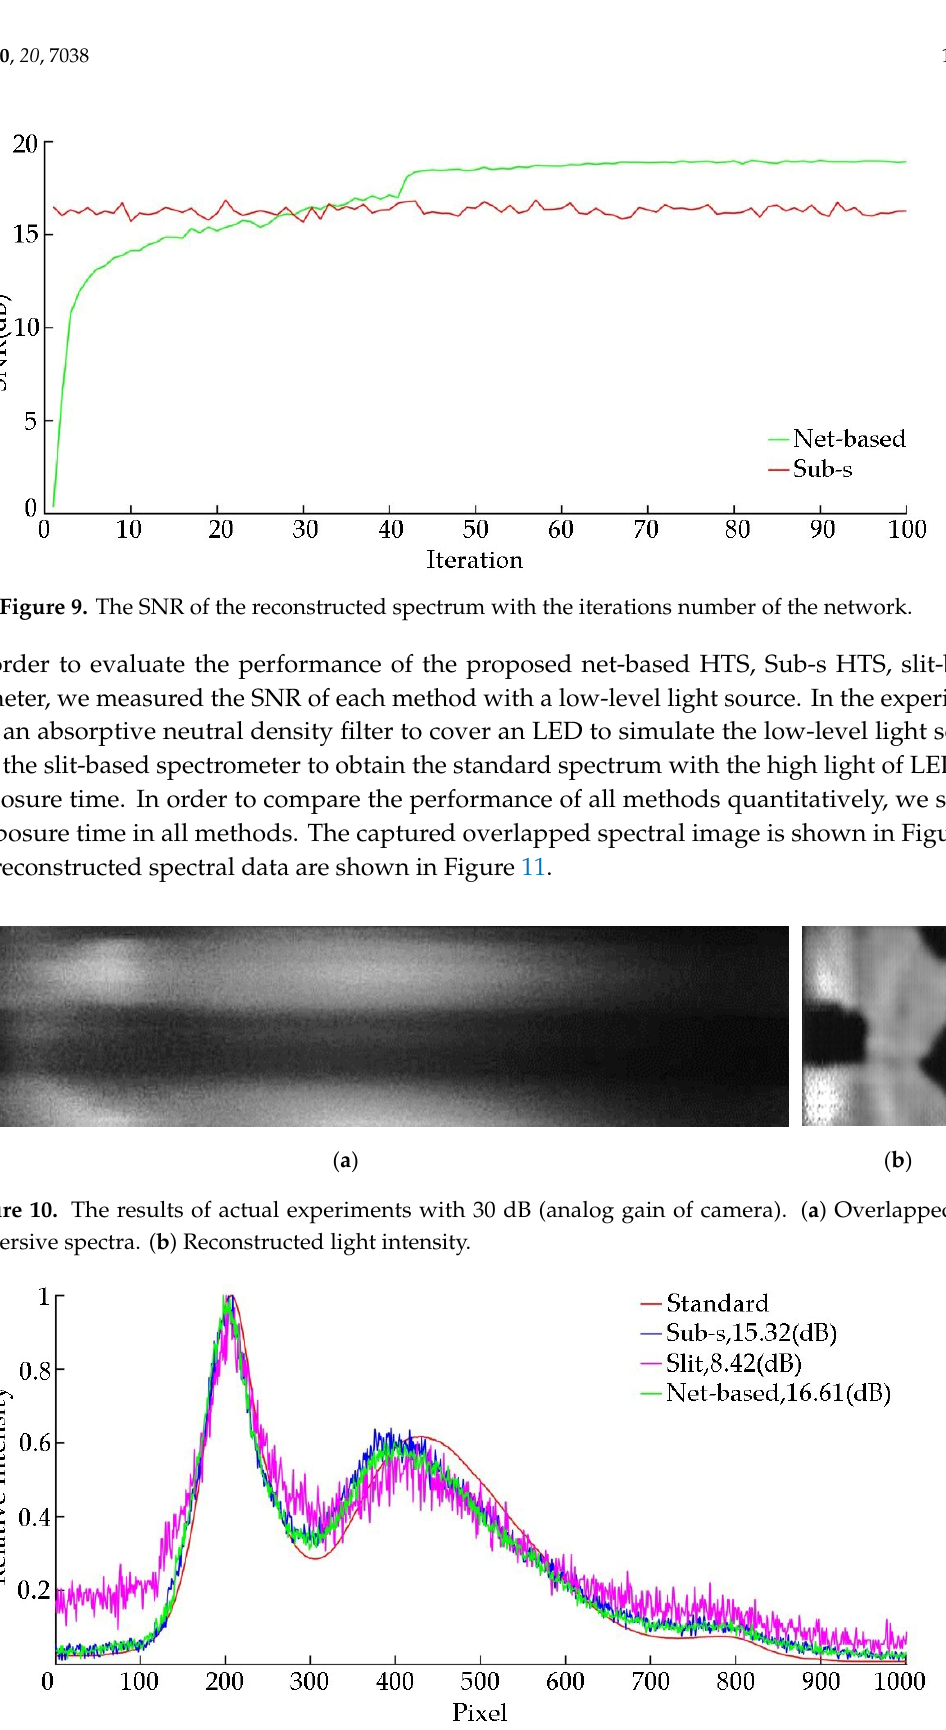
Figure 11. Experimental results of the proposed method, snapshot HTS and slit-based spectrometer with 100 us (exposure time of camera) and 30 dB (analog gain of camera).